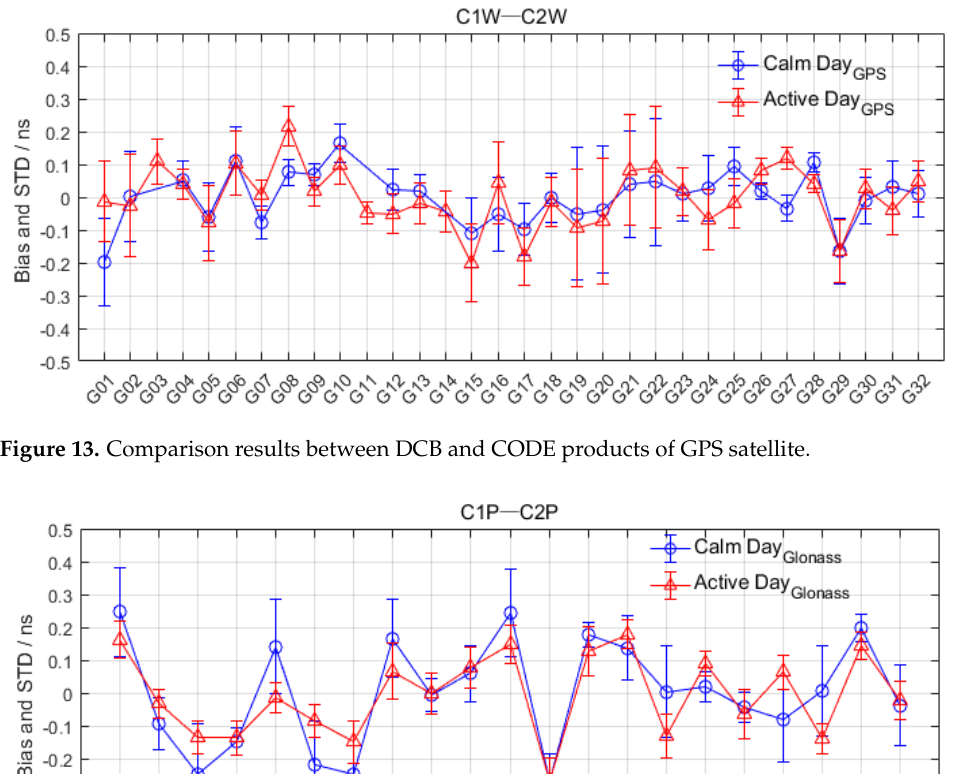
Figure 12. DCB time series of GLONASS satellite at different ionospheric conditions.